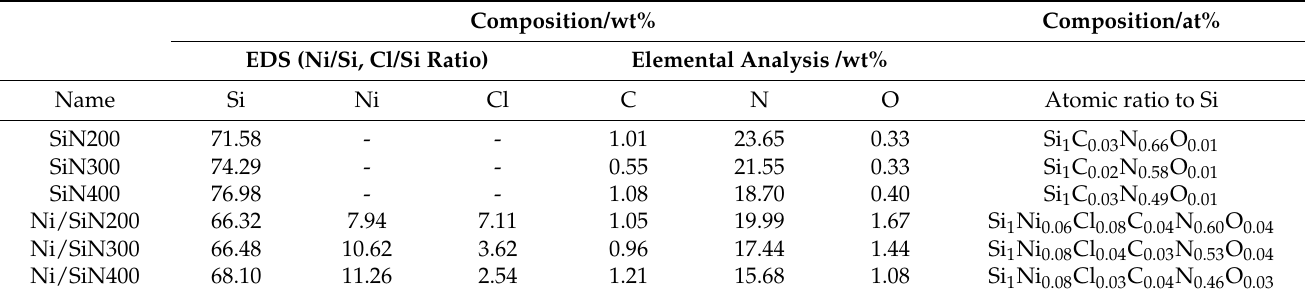
Figure 3. Powder X-ray diffraction patterns of Ni/SiNX samples pyrolyzed at 200, 300, 400 °C: 2θ = ( a ) 10 – 90° and ( b ) 35 – 55°. The average crystallite size was calculated for the Ni (111) plane by using the Scherrer equation, and the initial average crystallite size at 300 °C of 18.4 nm was evaluated for the Ni/SiN300 sample, then the crystallite size reached 18.5 nm at 400 °C ( Ni/SiN400 sample). 3.4. Mechanistic Investigation of the in Situ Formation of Nanocomposites Interestingly, FTIR spectroscopy and TG-MS analysis suggested that NiCl 2 may pro- duce a Ni nitride as a consequence of potential interactions with ((≡Si) 3 N:) or N-H bonds; a Ni nitride compound was not detected as an intermediate by the XRD analysis (Figure 3). Within this context, we conducted further investigation focused on the 0.05NiPHPS sample, the intermediate states ( Ni/SiN200 and Ni/SiN300 samples) and the Ni/a-SiN nanocomposite ( Ni/SiN400 sample) and obtained a clear understanding of the in situ for- mation pathway by the Raman spectroscopic analysis (Figure 4).